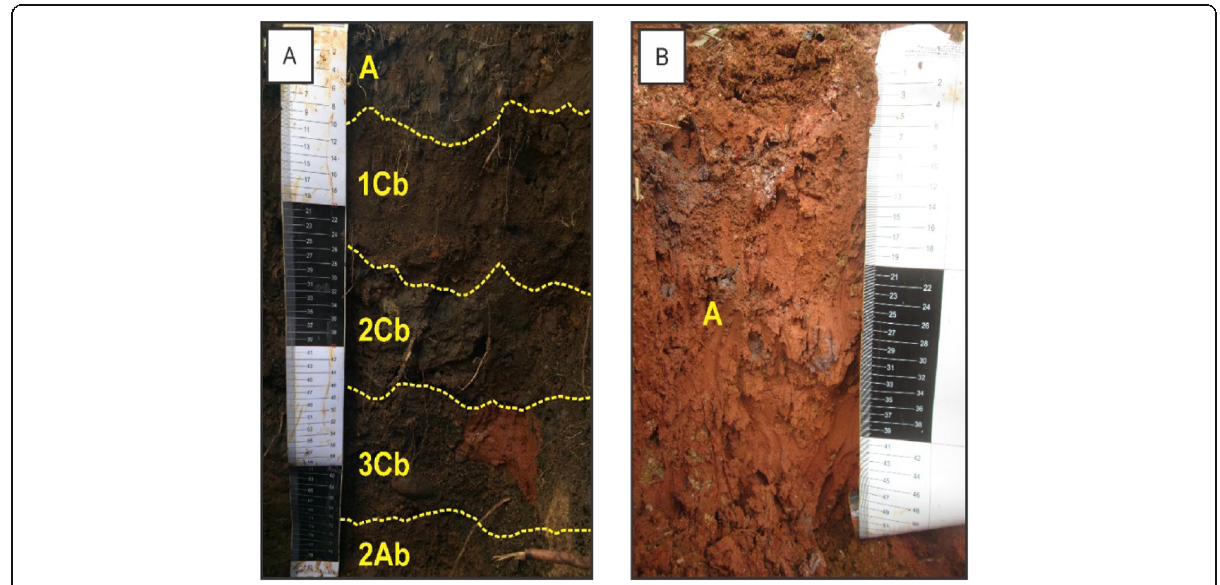
Fig. 10 Soil morphology on toe parts of landslide: Tegalsari ( a ) and Wonogiri ( b ). Note: Soil profile in Tegalsari shows superposition of mass movements and rock fragments. Soil profile in Wonogiri shows pedoturbated